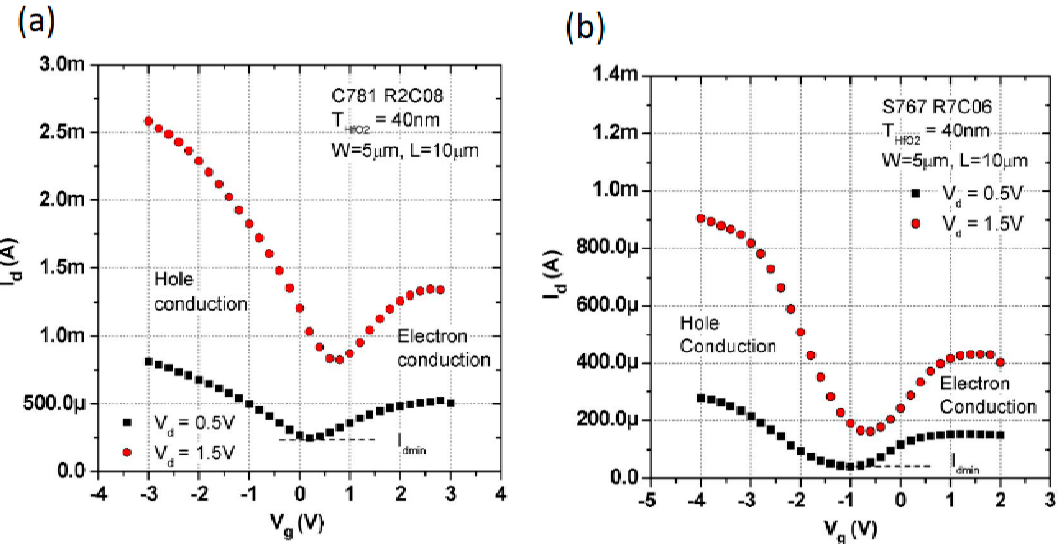
Figure 20. Id − Vg characteristics for FET fabricated on ( a ) MEG on SiC (0001) transistor for 0.5 V and 1.5 V drain voltages, ( b ) EG on SiC (0001) transistor for two drain voltages. Reprinted with permission from Reference [60]. Copyright (2008) Institute of Electrical and Electronics Engineers.